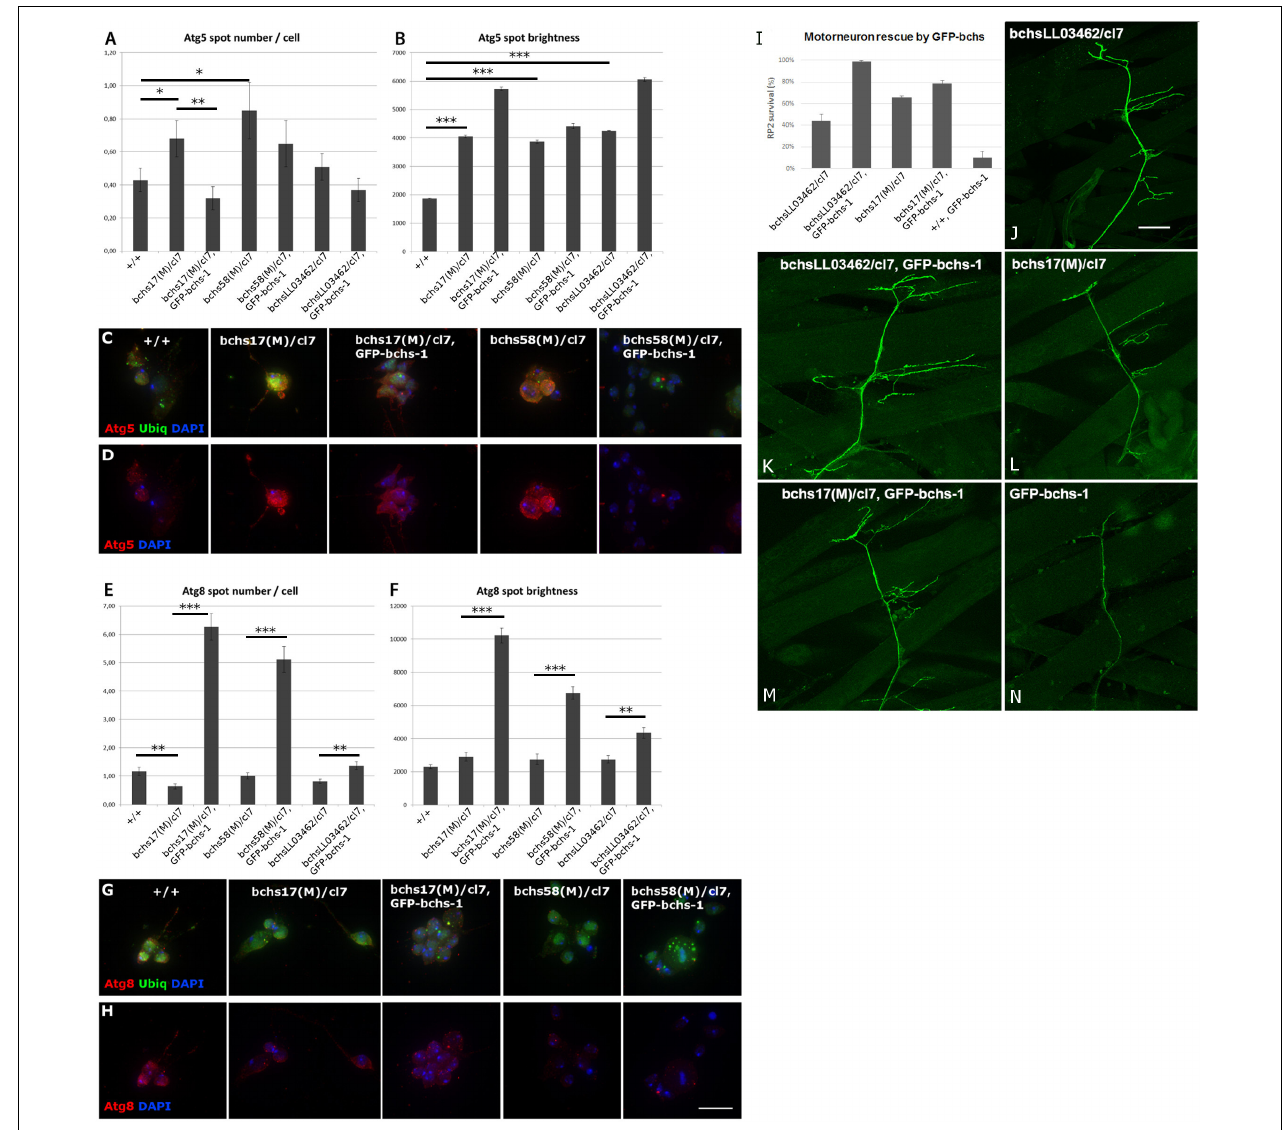
FIGURE 4 | Full-length Bchs drives an increase in transition of early Atg5-positive vesicles to Atg8-carrying autophagosomes, and full-length Bchs rescues bchs neuronal loss, but kills motor neurons in a wild-type background. (A,B) Early autophagic Atg5-positive vesicle number and brightness (fluorescence intensity per pixel within a spot) in primary larval neurons, with examples of neurons of individual genotypes (C,D) , also labeled with anti-poly-ubiquitin (green) and DAPI (blue) to show cell locations. ∗ p < 0.05, ∗∗ p < 0.01, ∗∗∗ p < 0.001. (E,F) Late autophagic Atg8-positive vesicle number and brightness in the same genotypes as in (A,B) ; examples shown in (G,H) . Atg5/Atg8 and DAPI are shown separately to make changes in abundance of the respective marker more visible. Scalebar = 10 µ m. (I–N) RP2 motor neuron survival after GFP-bchs-1 expression via eve-Gal4 in bchs mutant backgrounds bchsLL03462/cl7 , bchs17(M)/cl7 , or in the control background (+ / +). (J–N) Images of representative neuromuscular junctions in the larval body wall labeled with eve > GFP in the same bchs backgrounds, with or without GFP-bchs-1. Scalebar = 20 µ m.